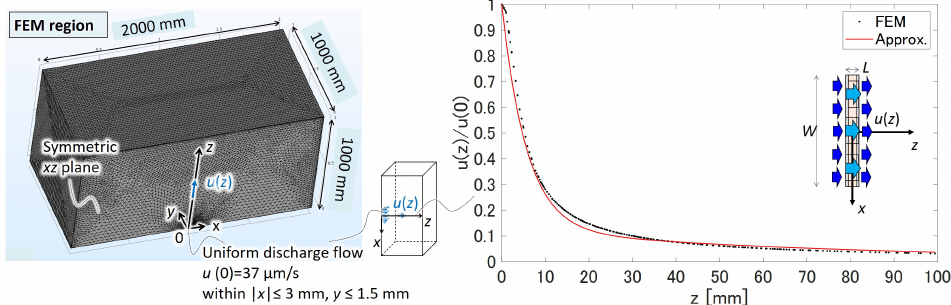
Figure 3. Velocity decay characteristic along the vertical direction ( z ) away from the pump ar- ray estimated using finite element method (FEM) analysis of laminar flow using COMSOL Multi- physics (COMSOL, Inc., Stockholm, Sweden). The lateral size of the pump array was 3 mm and u ( 0 ) was set as 37.0 µ m/s. The approximation curve was identified as 0.875exp( − z /5.71 mm) + (1 − 0.875)exp( − z /81.3 mm). The approximation was performed using the Curve Fitting Toolbox